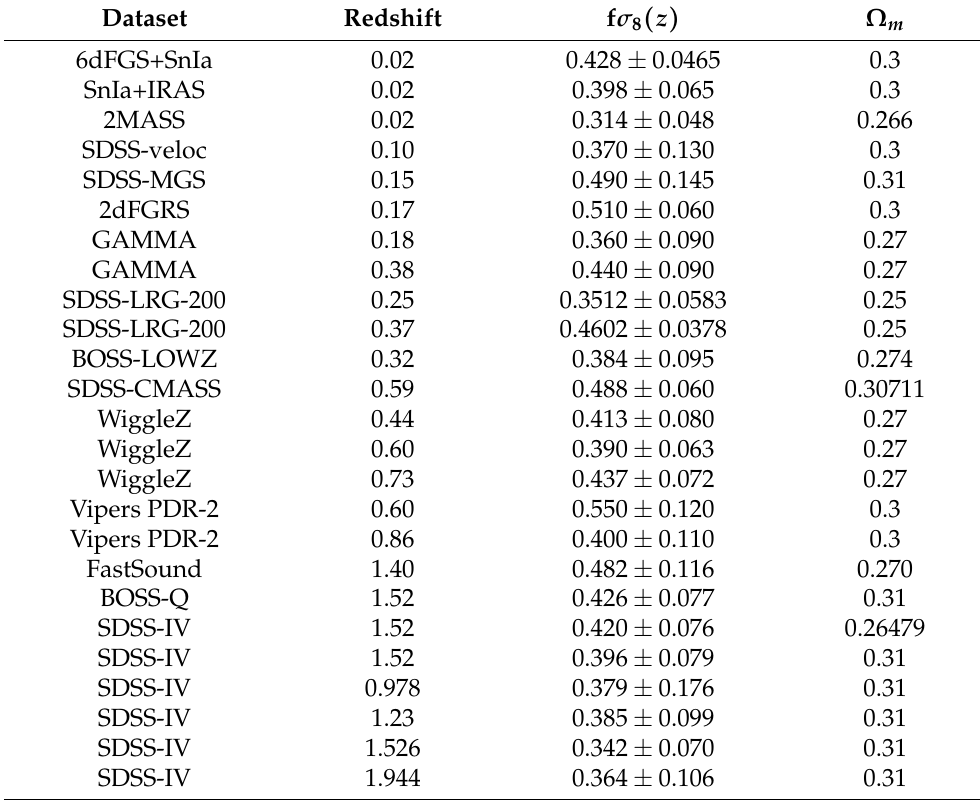
Table 3. Data points of the “extended Gold-2018” compilation to the Planck 2018 (TT, TE and EE+lowE) best-fit parameters [96] with additional points from BOSS Q [70] and SDSS-IV